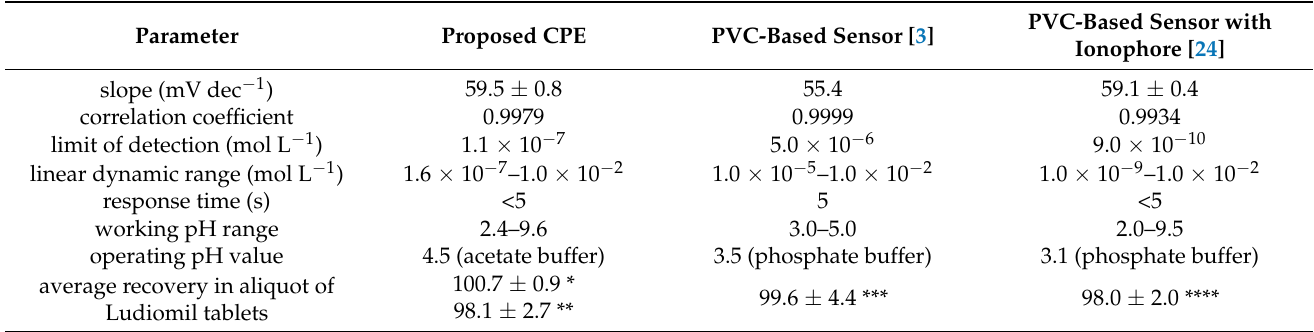
Table 5. Statistical comparison between the potentiometric characteristics by the CPE prepared in this work and PVC-based sensors for maprotiline determination from the